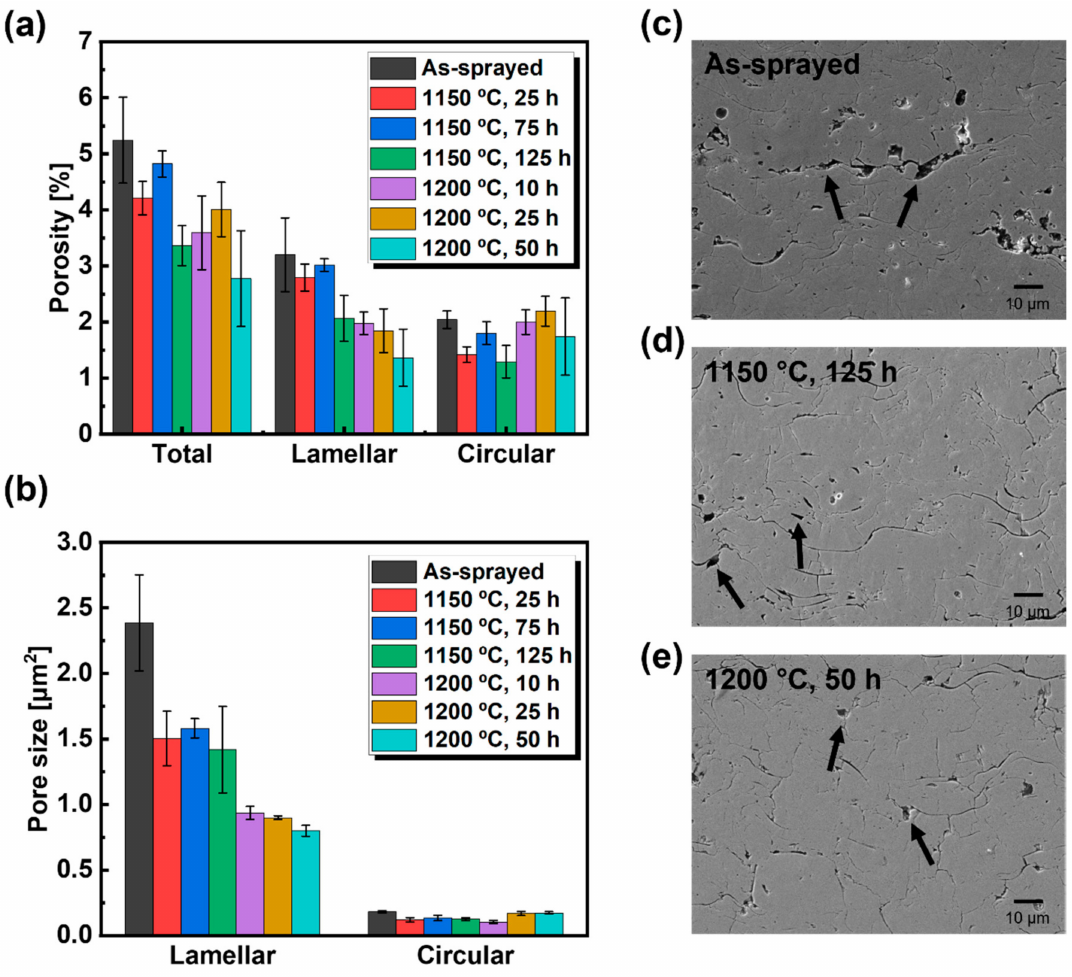
Figure 7. ( a ) Porosity and ( b ) pore size of YSZ samples. Cross-sectional SEM images of samples ( c ) as-sprayed and heat-treated at ( d ) 1150 ◦ C for 125 h and ( e ) 1200 ◦ C for 50 h. Arrows indicate lamellar